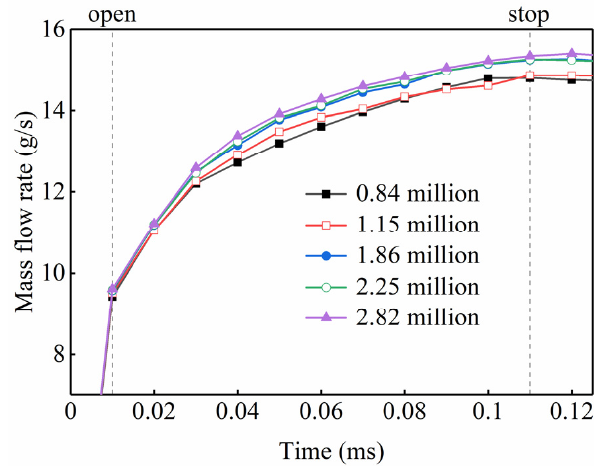
Figure 3. Comparison of the mass flow rate of the outlet throttle.